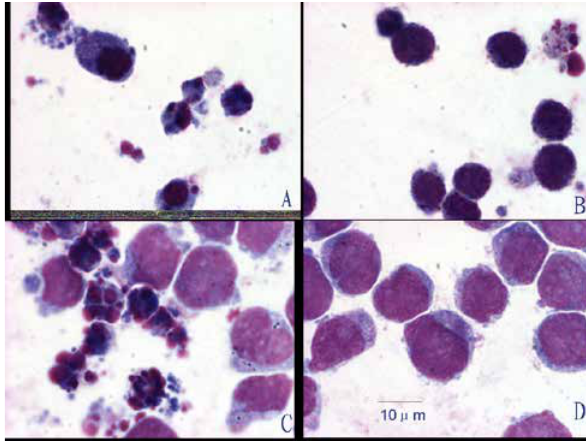
Table 3: The change of differentiation antigen on HL-60 cell surface